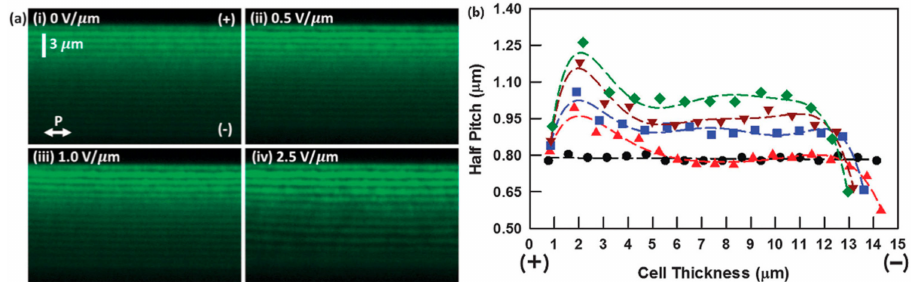
Figure 2. ( a ) Map of the fluorescence intensity by three-photon excitation along a 2D cross-section of a PSCLC without or with an applied electric field (reflection notch at 2.45 µ m at zero field and ~15 µ m cell thickness). The vertical direction is along the cell normal and the helical axis, the horizontal direction is parallel to the cell substrates. The white arrow labeled “P” in (i) is the polarization direction of the excitation light. The polarity of the DC voltage is indicated by the “( + )” and “( − )“ signs. ( b ) Magnitude of the half-pitch through the cell thickness as obtained from the fluorescence images in ( a ) for the following values of the electric field: ( • ) 0 V µ m − 1 , ( (cid:78) ) 0.5 V µ m − 1 , ( (cid:4) ) 1.0 V µ m − 1 , ( (cid:72) ) 2.0 V µ m − 1 , and ( (cid:117) ) 2.5 V µ m − 1 . Composition of the CLC mixture: 0.2 wt% I-369, 4 wt% SL04151, 2 wt% RM23, 2 wt% CB15, and 91.8 wt% MLC 2079. The PSCLC was formed by curing the mixture with exposure to 365 nm UV light at 100 mW cm − 2 for 5 min. Reproduced from Ref. [25] with permission from the Royal Society of